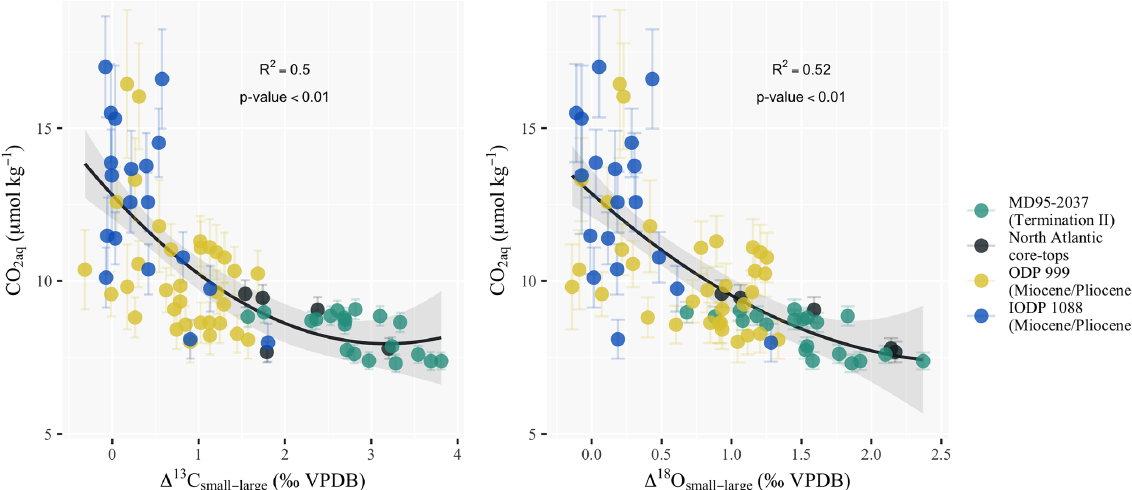
Figure 5. Coccolith differential vital-effect sensitivity to changes in aqueous CO 2 since the Miocene. Differential vital effects are more important in the Late Pleistocene and modern-day ocean than during the Miocene. The correlation between aqueous CO 2 and differential vital effects in carbon ( R 2 = 0 . 5) or oxygen ( R 2 = 0 . 52) suggests that an increase in carbon limitation might be responsible for the observed change. Coccolith vital-effect datasets are from Bolton et al. (2012) for the Miocene and Pliocene and Candelier et al. (2013) and Hermoso et al. (2015) for the North Atlantic core tops. The pCO 2 records used to compute aqueous CO 2 for the Miocene and Pliocene datasets are from Rae et al. (2021). SST data for site 1088 are from Herbert et al. (2016). For site 999 we took the composite SST record from Rae et al. (2021), as no SST dataset spanned the whole of the differential vital-effect record for site 999. Core-top CO 2 concentrations were calculated using a pre-industrial pCO 2 of 280ppm and SST data from WOA13 (Locarnini et al.,